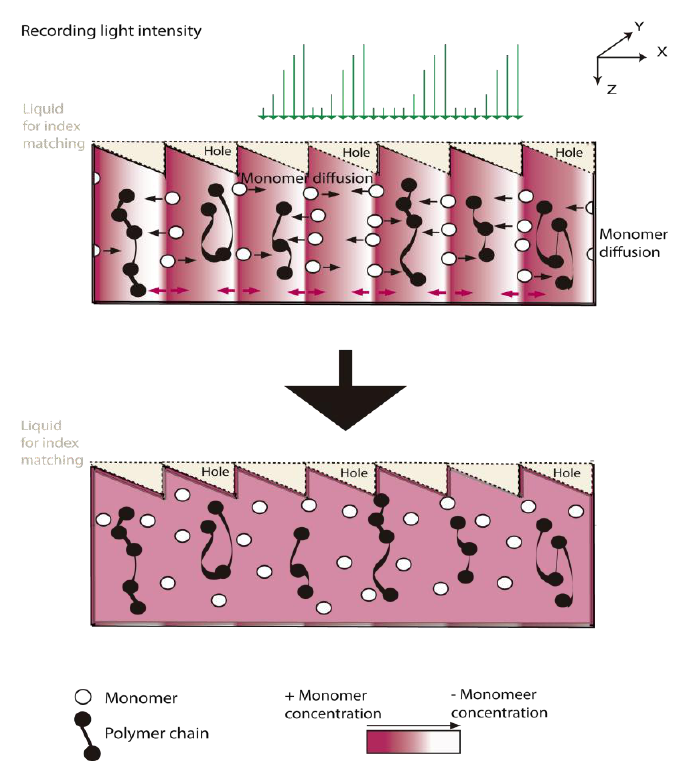
Figure 3. Diagram of the blazed grating recording in the photopolymers with index matching. The “apparent” diffusion is due to the recovering surface changes and the “real” diffusion to the internal monomer motion.